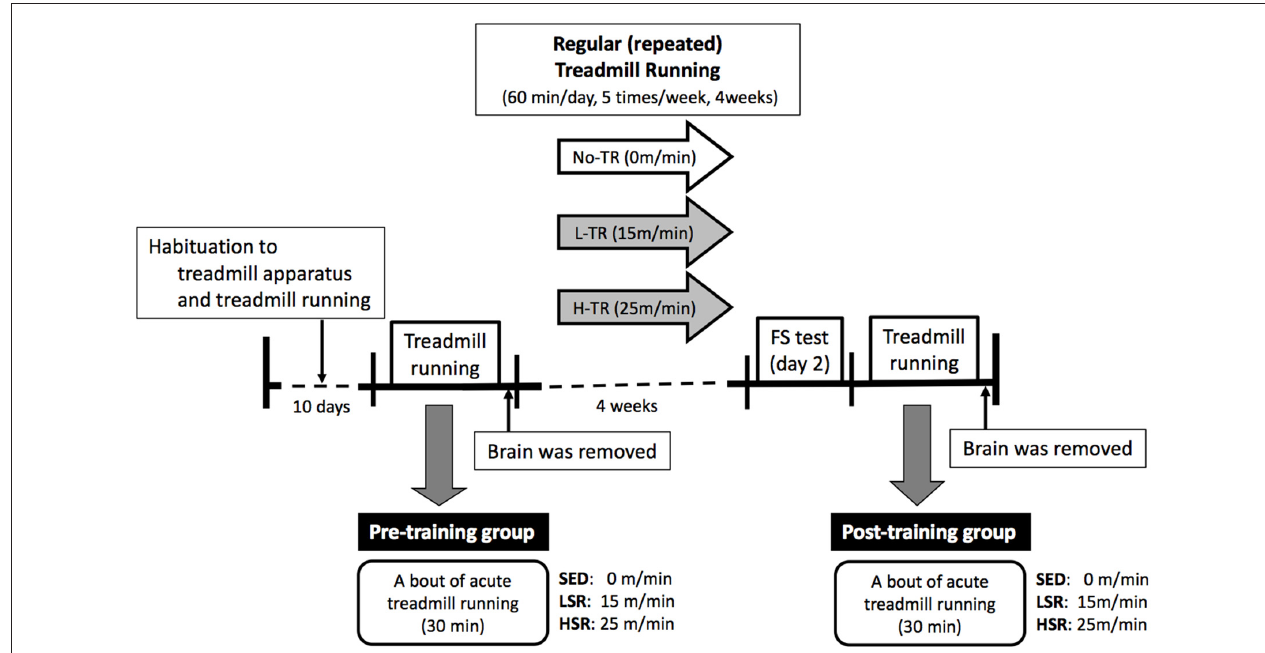
FIGURE 1 | Time line of the experiment. The rats were habituated to the treadmill apparatus and treadmill running for 10 days. Then, a session of 30-min treadmill running (LSR, low-speed runners; HSR, high-speed runners) or sitting (SED, sedentary controls) on the treadmill was performed in half of the rats as the pre-training group. The brains of rats were removed following this single session of treadmill running. The remaining half of the rats performed regular treadmill running at different intensities for 4 weeks (H-TR, high intensity; L-TR, low intensity; No-TR, sedentary; 60 min/day, 5 times/week). After the training session, the rats performed a behavioral test (i.e., forced swim test) and acute treadmill running (the same regimen as in the pre-training group) as the post-training group. Two or more days after the behavioral testing, the brains were removed following a session of acute treadmill